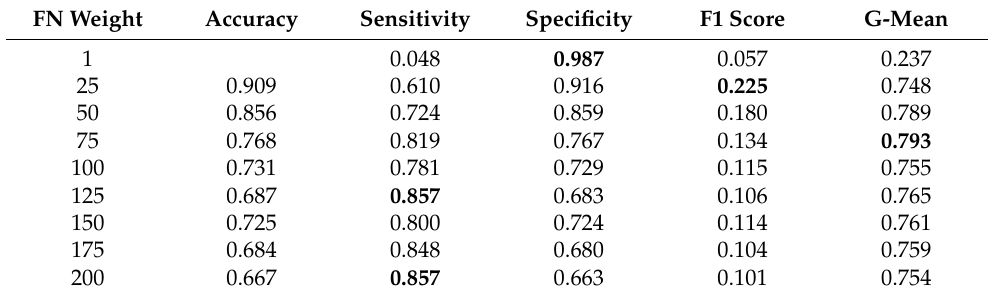
Table 3. The effects of the weight of false negative predictions on all metrics using the CSO (for the dataset of Spanish companies). The best result for each metric is marked in boldface.